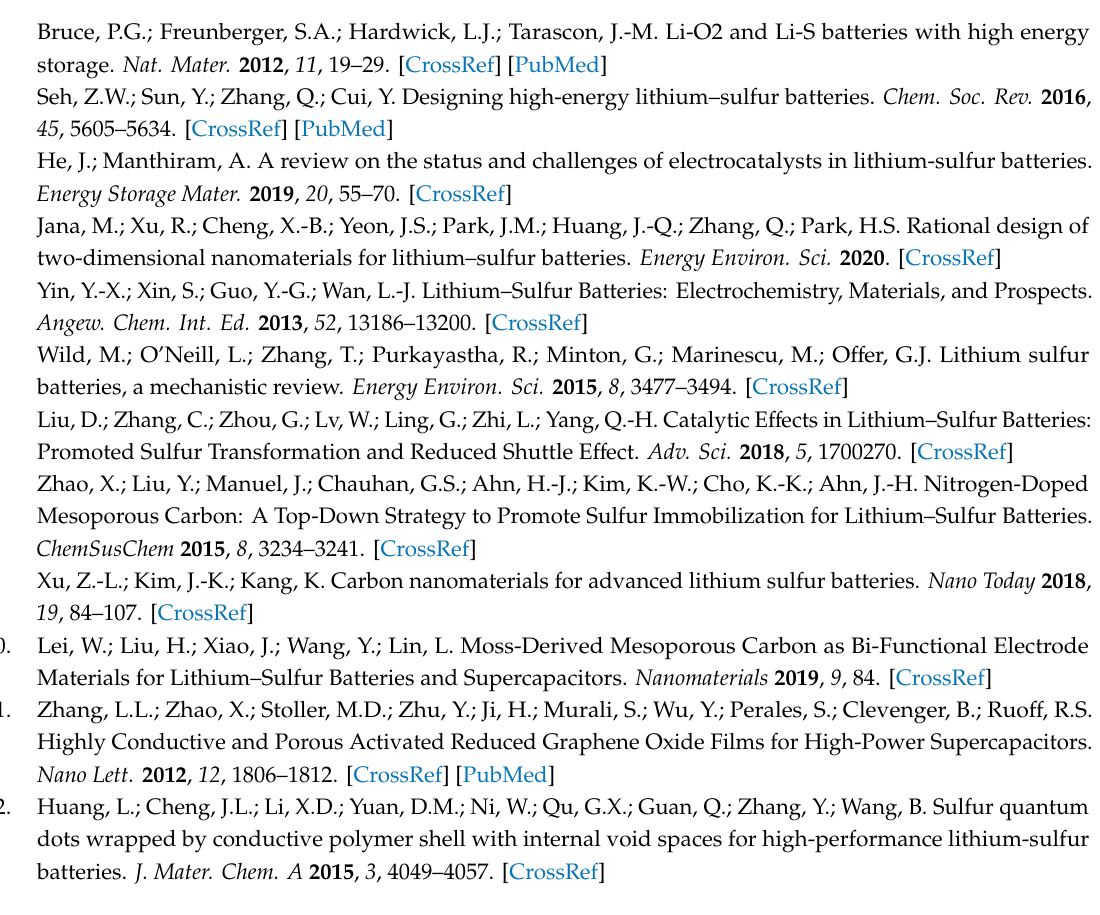
Figure S1: SEM EDS spectrum of CSC / S sample. Figure S2: Pore size distribution plots of ( a ) CSC and ( b ) CSC / S. Figure S3: ( a ) XPS Survey of CSC, and ( b ) De-convoluted high-resolution C 1s XPS spectra of CSC. Figure S4: Raman spectrum of CSC sample showing the presence of G- and D-bands. Figure S5: Comparison of cyclic stability (0.2C) of CSC / S activated with di ff erent chemical agents. Table S1: Electrolyte solution resistance, and charge transfer resistance of CSC / C before and after CV. Table S2: Table comparing the textural properties of CDC, and electrochemical performance of CSC / S with other bio-mass